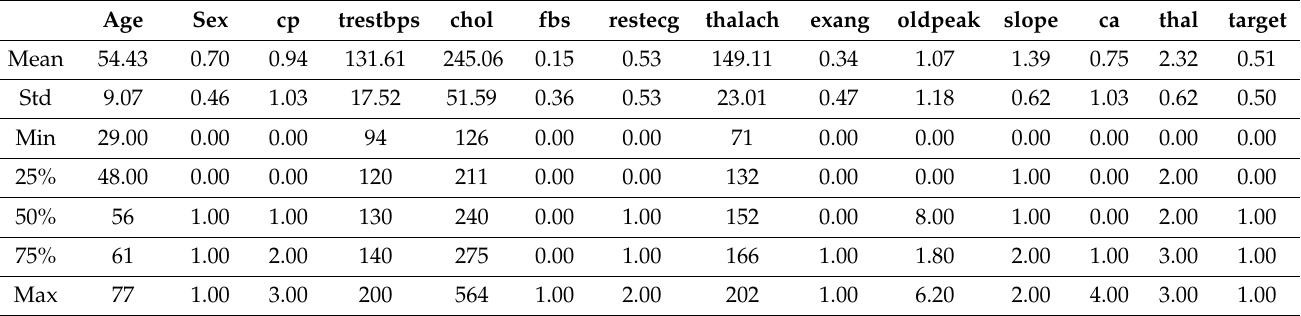
Table 3. The description of dataset-II for the count (1025), minimum, maximum, mean, and standard